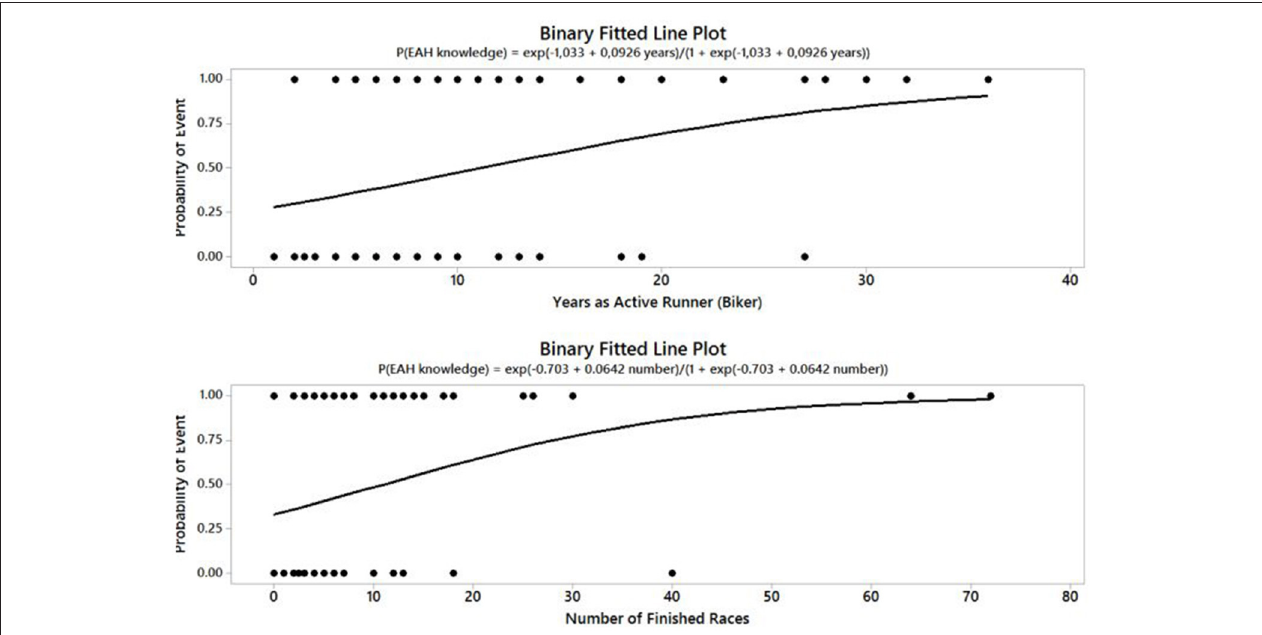
FIGURE 1 | Probability model of reported affirmative answers to questions on the knowledge of EAH ( n = 138) considering the number of years as an active runner/biker ( p = 0.002) and the number of similar completed races ( p < 0.001).